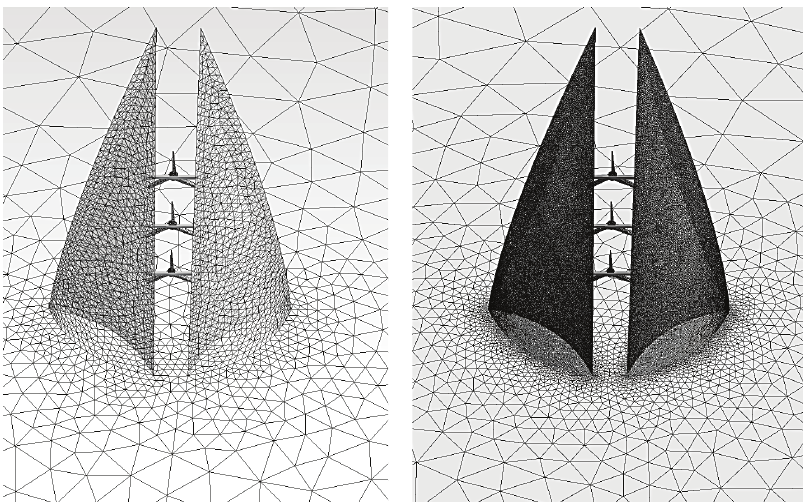
Figure 5: Low and high volume mesh for grid independence test.